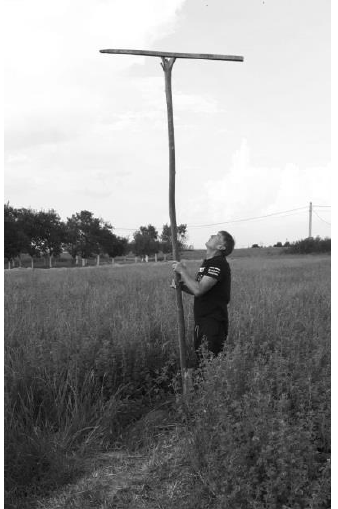
Figure 1. Installed T-standpoint in